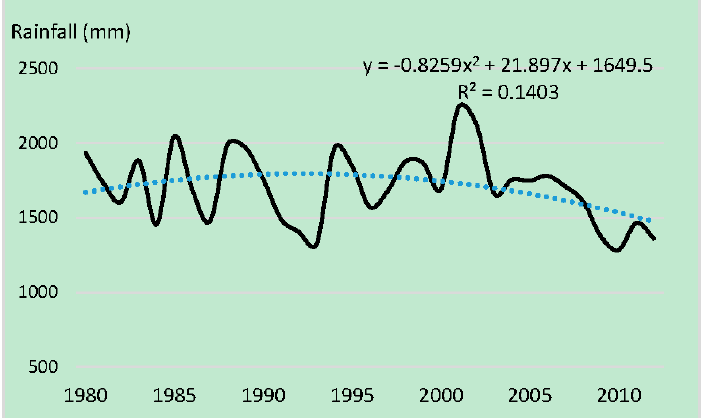
Figure 3. Annual rainfall of 1980–2012 at Mae Chan Hill tribe Development station.